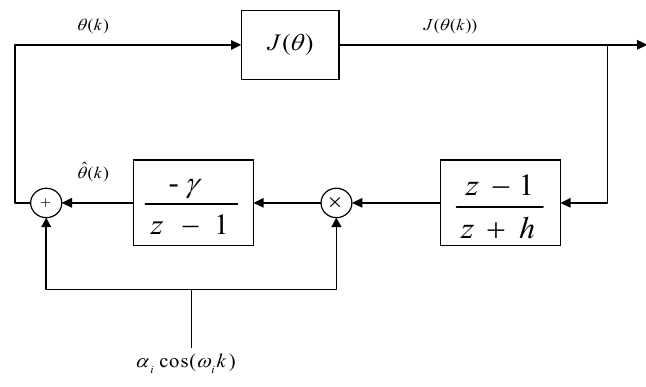
Figure 4. Diagram of the multi-parameter extremum-seeking algorithm.